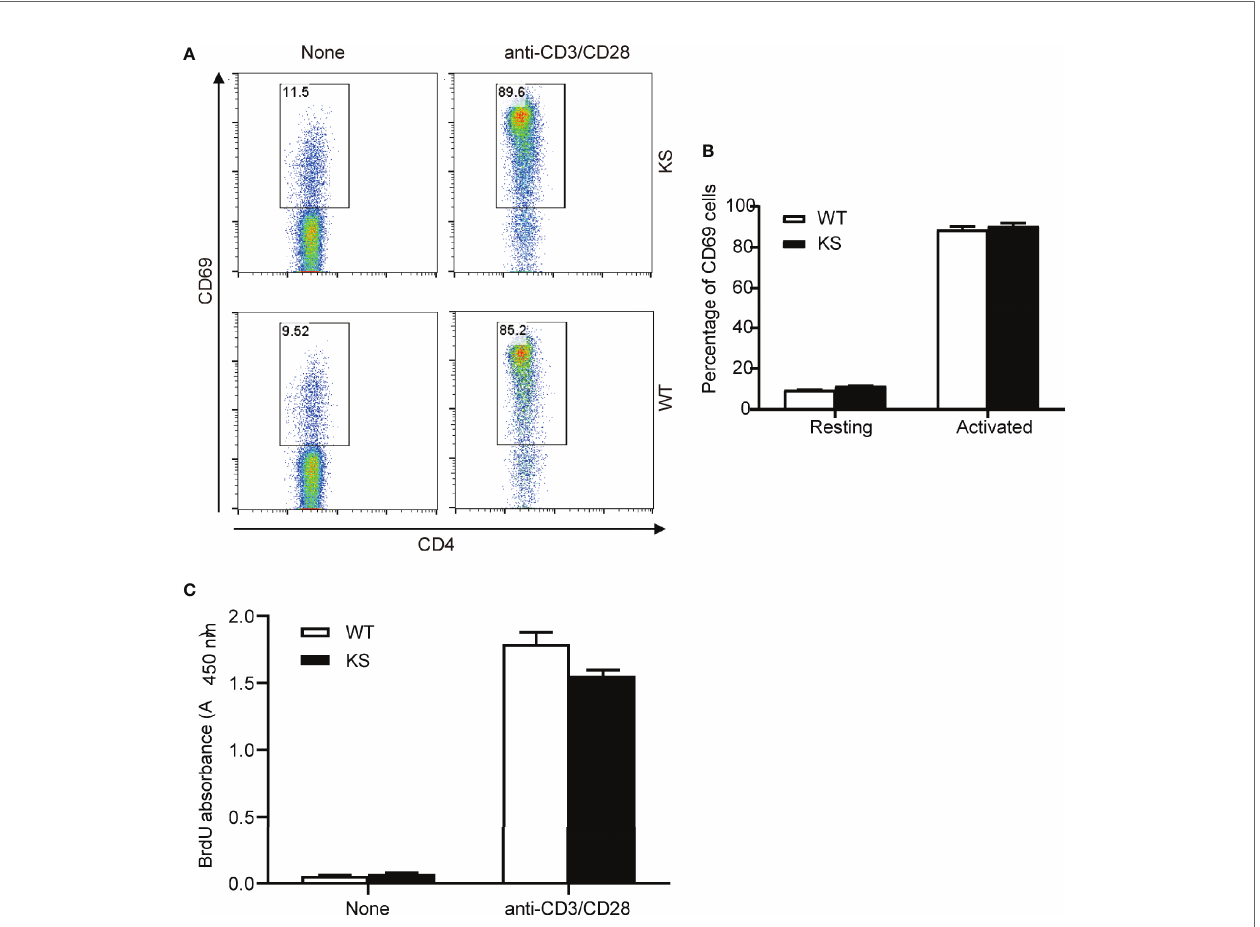
FIGURE 8 | Effects of Kallistatin overexpression on T cell activation and proliferation of naïve mice. CD4 + T cells puri fi ed from naïve WT and KS mice were stimulated without (None) or with anti-CD3 and anti-CD28 mAbs. (A, B) After stimulation for 5 h, cells were collected and washed, followed by staining for CD69 and fl ow cytometry analysis. Representative FACS plot (A) and bar diagram (B) for frequencies of CD69 + T cells are shown. (C) After stimulation for 24 h, the proliferation of T cells was detected by BrdU incorporation. Data are representative from three independent experiments and shown as mean ± SEM. (Unpaired Student ’ s t